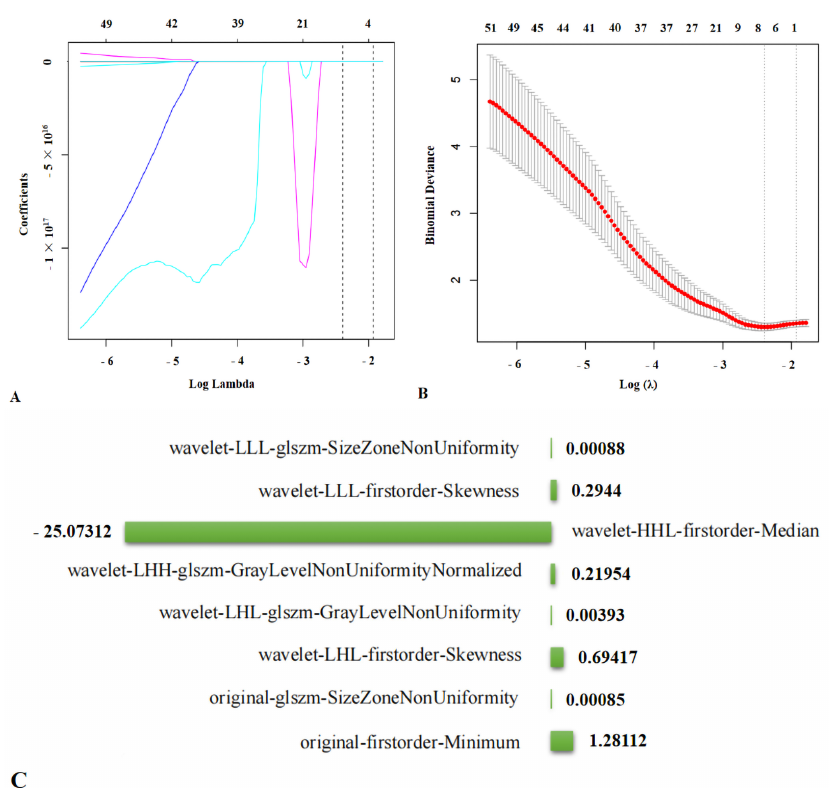
Figure 3. Feature selection process of radiomics in predicting intermediate-high SS. ( A , B ) An optimal tuning parameter ( λ ) value of 0.0914, with log( λ ) = − 2.3925 was determined by ten-fold cross-validation via minimum mean cross-validated error in LASSO model. Eight features that were most capable of predicting intermediate-high risk of coronary atherosclerosis were selected from 851 features. ( C ) The coefficients of the 8 features.